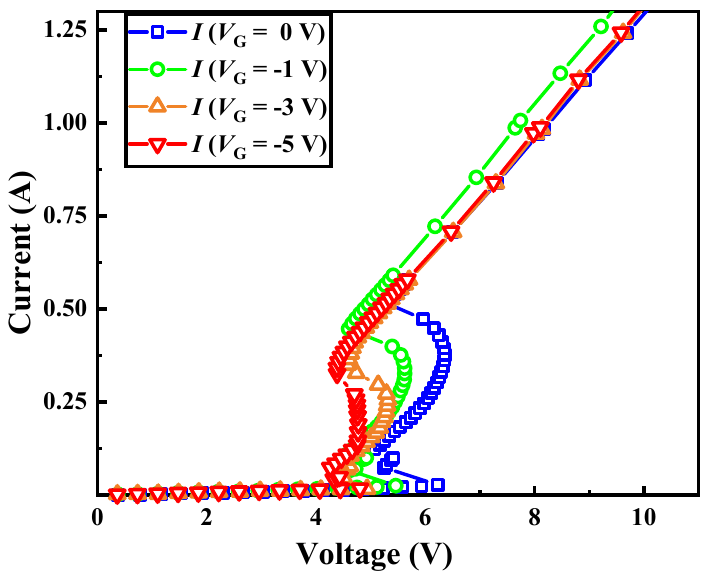
Figure 6. TLP I-V curves for the PTBSCR (L = 0.5 μ m) with different gate voltages.